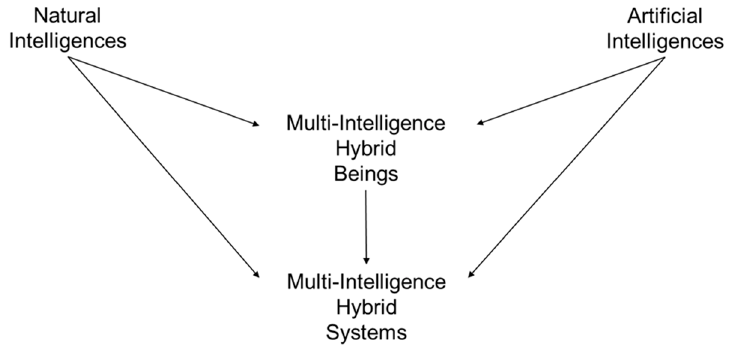
Figure 1. Multi-Intelligence (MI) hybrid beings and systems.